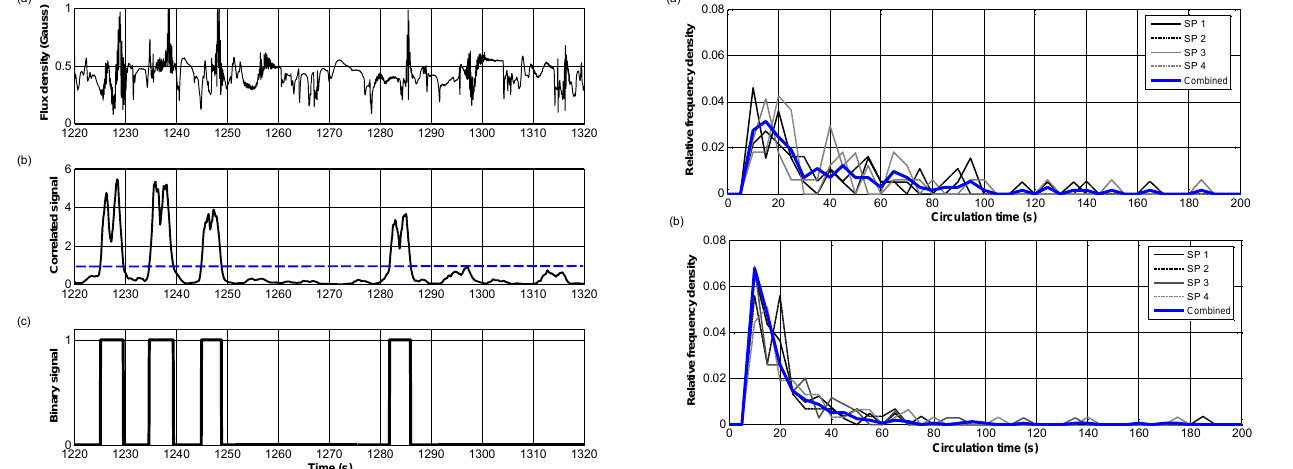
Figure 9. Sequence of the analysed magnetic field signal of a sen- sor particle for detection of a position marker for the horizontal flow in the biogas digester: (a) magnitude of the magnetic flux density, (b) correlated signal with the threshold for binarization and (c) bi- nary signal.